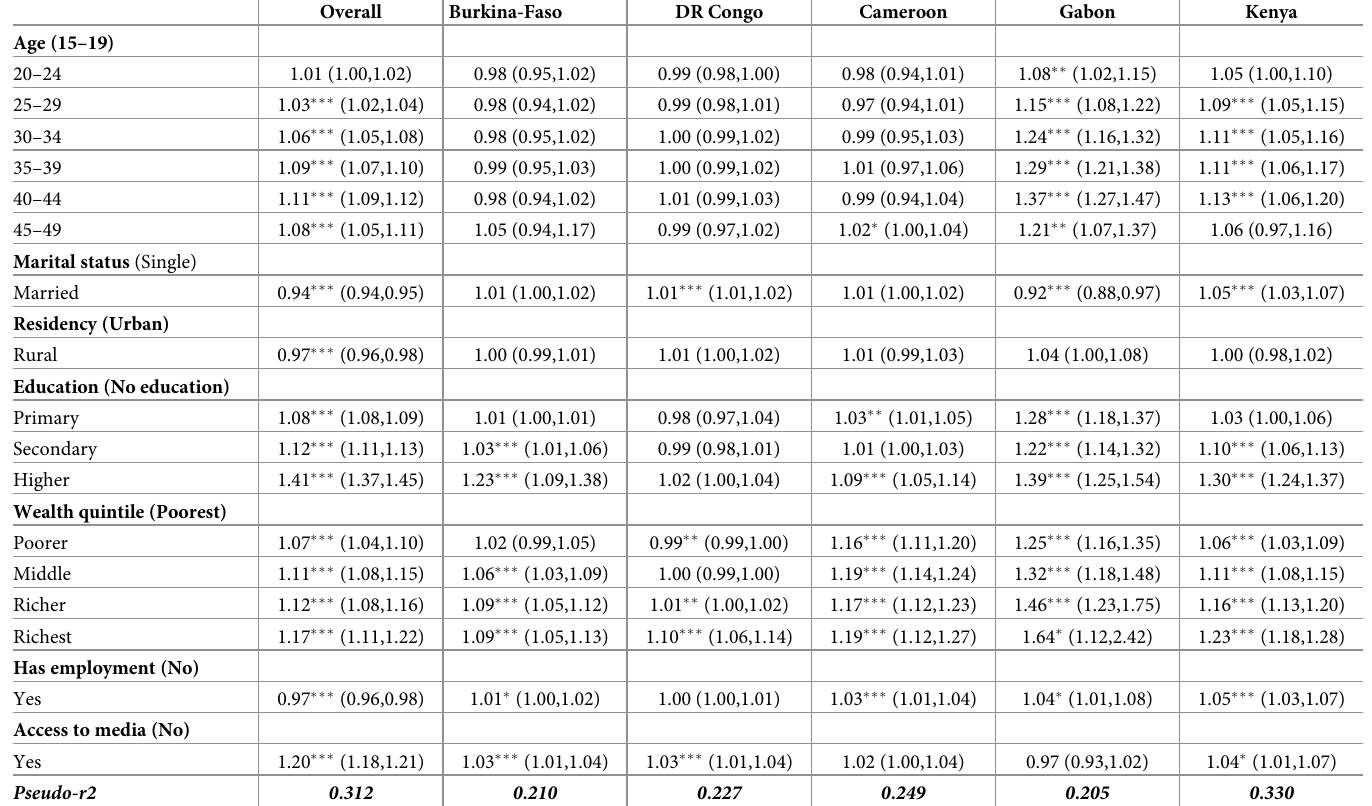
Table 3. Results of multivariate logistic regression estimations of the proportions of insurance ownership regressed on the sociodemographic factors in five SSA